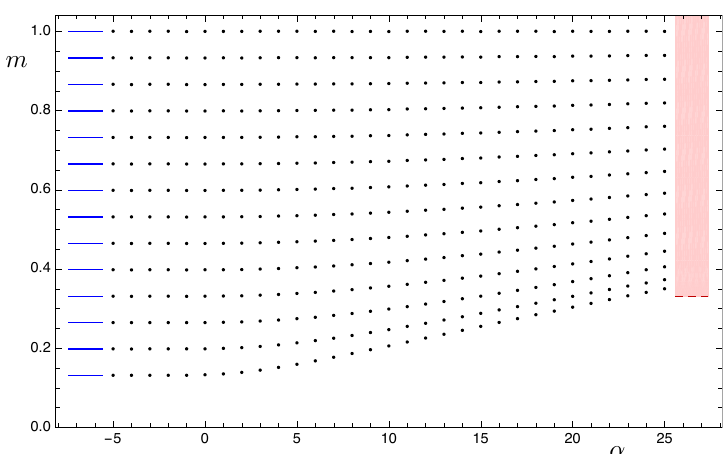
Figure 4 . Mass spectrum m of tensor modes for di(cid:11)erent baryonic branch solutions constructed by changing (cid:11) . The normalization is discussed in the main text. By way of comparison, we show also the KS spectrum (in blue, far left) and the CVMN spectrum (in red, far right). Notice that the latter has a threshold above which a continuum appears (shaded